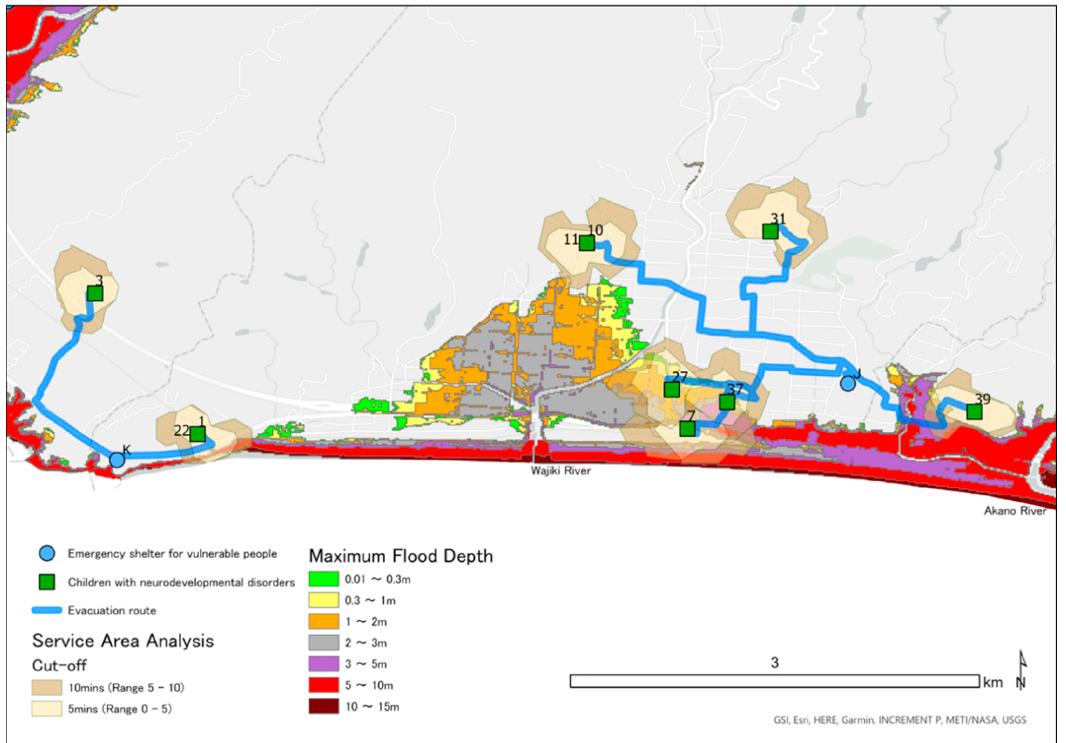
Figure 4. Service area analysis of emergency shelters for vulnerable people (ESVPs) in Geisei and evacuation routes to nearby ESVPs.